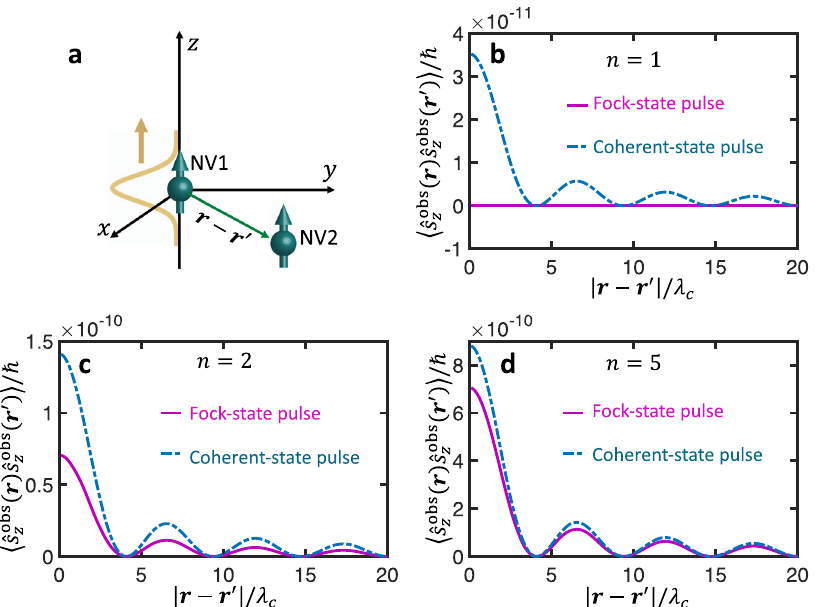
Fig. 6 Non-local spin noise. a Our proposed spin density correlation measurement with two nitrogen-vacancy (NV) centers (NV1 and NV2) at r and r 0 , respectively. b − d Contrast of spin density correlation between Fock-state and coherent-state pulses. Here, n is the mean photon number in each pulse and we show the results for the case with m = 1 and θ c = 0.2 π . One of the quantum sensor is fi xed on the z -axis and the other sensor can move in xy